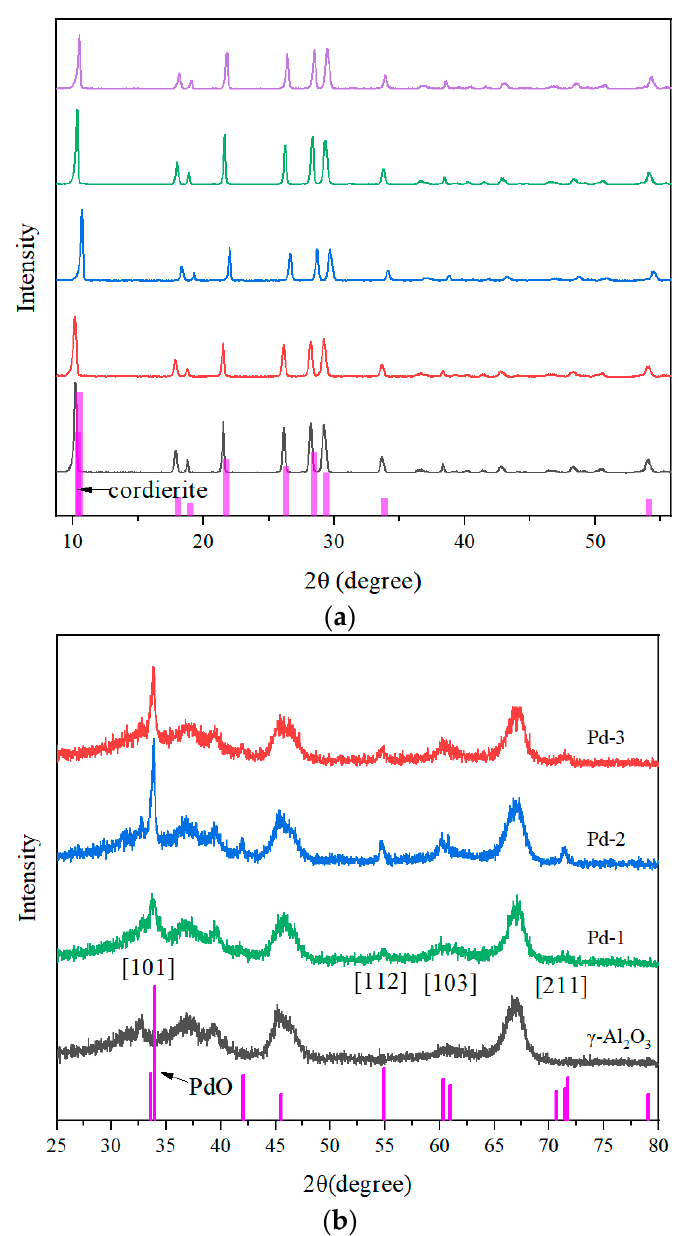
Figure 1. ( a ) X-ray diffraction patterns of COR, Al 2 O 3 /COR, Pd-1, Pd-2 and Pd-3. ( b ) X-ray diffraction patterns of γ -Al 2 O 3 , Pd-1, Pd-2 and Pd-3 de-cordierite samples. The coating on the catalysts was scraped off and characterized by XRD, and the results are shown in Figure 1b. With the background of γ -Al 2 O 3 , a series of characteristic peaks of PdO (ICSD/JCPDS#:75-0584) could be observed at 2 θ = 33.9 ◦ , 54.9 ◦ , 60.4 ◦ and 71.7 ◦